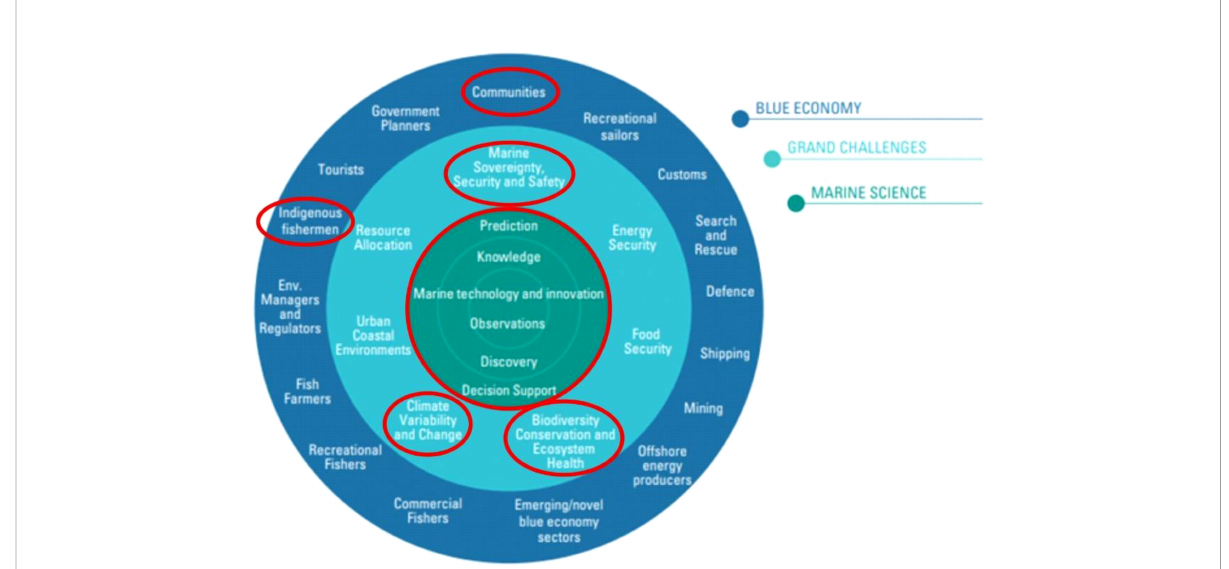
FIGURE 7 Schematic diagram outlining the range of stakeholder interests and science needs for Australia ’ s marine estate, with Indigenous interests in submerged cultural resources possibly (although not explicitly) coming under the banner of communities and biodiversity, conservation and ecosystem health. Circles indicate main elements that relate to Indigenous communities (modi fi ed from the National Marine Science Plan 2015-2025).